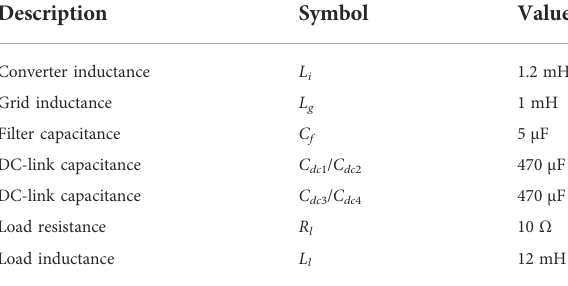
TABLE3Parametervaluesoftheconventional LCL fi lteredhalf-bridge